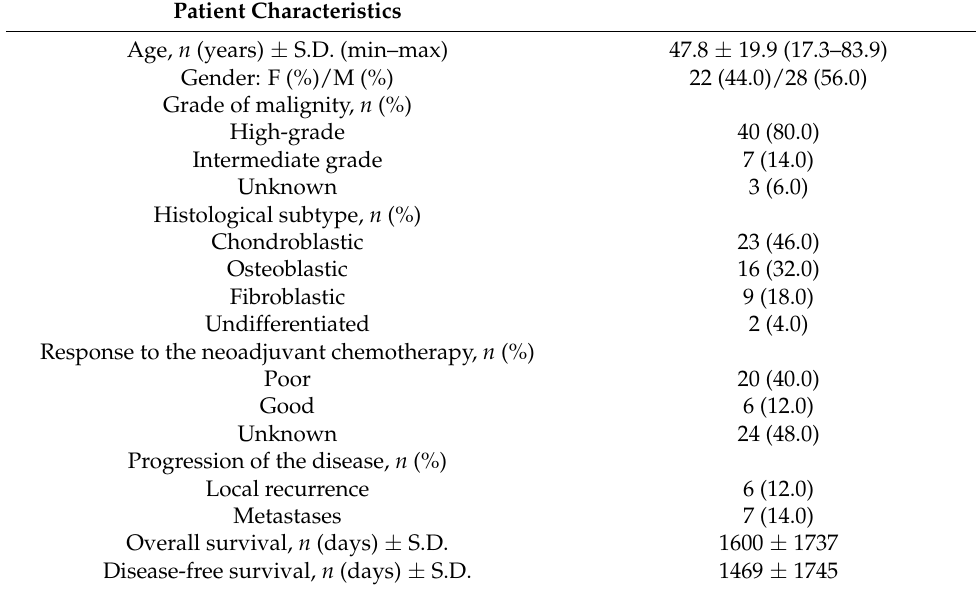
Table 1. Patient characteristics. n, number of patients; S.D., standard deviation; F, female; M, male.